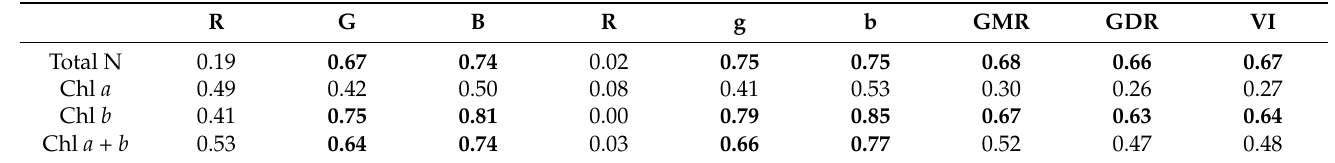
The values in bold correspond to the values higher than 0.60 at p < 0.05. Table 5. Equations and coefficient of determination (R 2 ) for the linear regression value between total N, Chl a , b and a + b (Y), and G and B (X) in M. senegalensis .